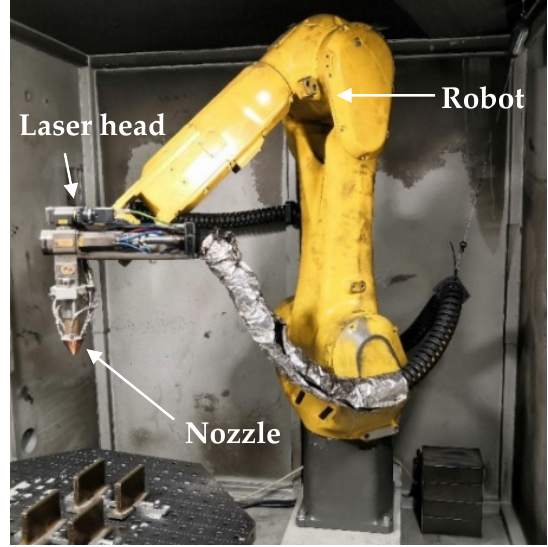
Figure 1. The robotic complex for direct laser deposition.